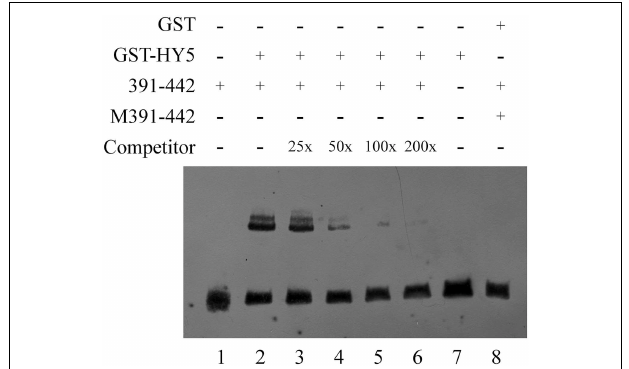
FIGURE 7 | EMSA confirmed the interaction between HY5 and the QH6 G-box motif in vitro . GST and GST-HY5 proteins were expressed and purified as described in the Materials and Methods Section. For each binding reaction, 5 µ g of recombinant protein was used. A double-stranded probe was generated by annealing synthesized single strand primers. The − 391 to − 442bp fragment of the QH6 promoter was biotin-labeled as 391-442, while M391-442 represents a mutant probe. In each lane, 20 fmol of biotin-labeled probe was used. In lane 1, only 20 fmol of the wild-type probe was used, while in lane 2, 20 fmol of the wild-type probe was used along with 5 µ g GST-HY5 protein. An unlabeled probe was used as a competitor as marked on the left. In lanes 3–6, unlabeled competitors (0.5 pmol, 1 pmol, 2 pmol, 4 pmol, respectively) were added to the binding assay with the GST-HY5 protein and the 391-442 biotin-labeled probe. The relative concentration ratio was marked as in the competitor row. Negative controls were 20 fmol mutant probe together with 5 µ g GST-HY5 protein (Lane 7) and 20 fmol wild-type probe with 5 µ g GST protein (Lane